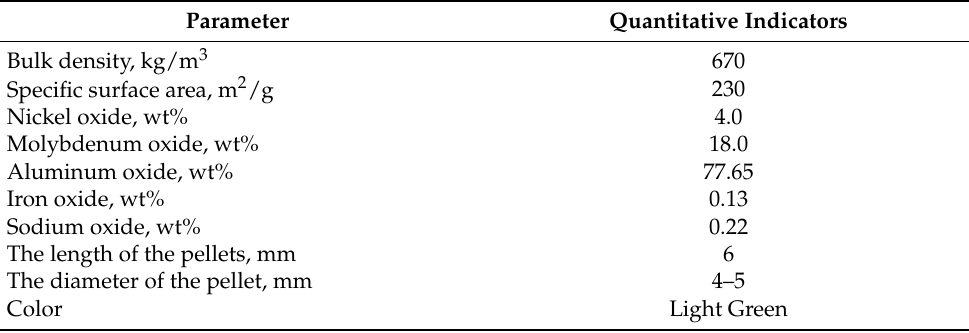
Table 3. Physical and chemical properties of Al-Ni-Mo-oxide catalyst. Parameter Quantitative Indicators